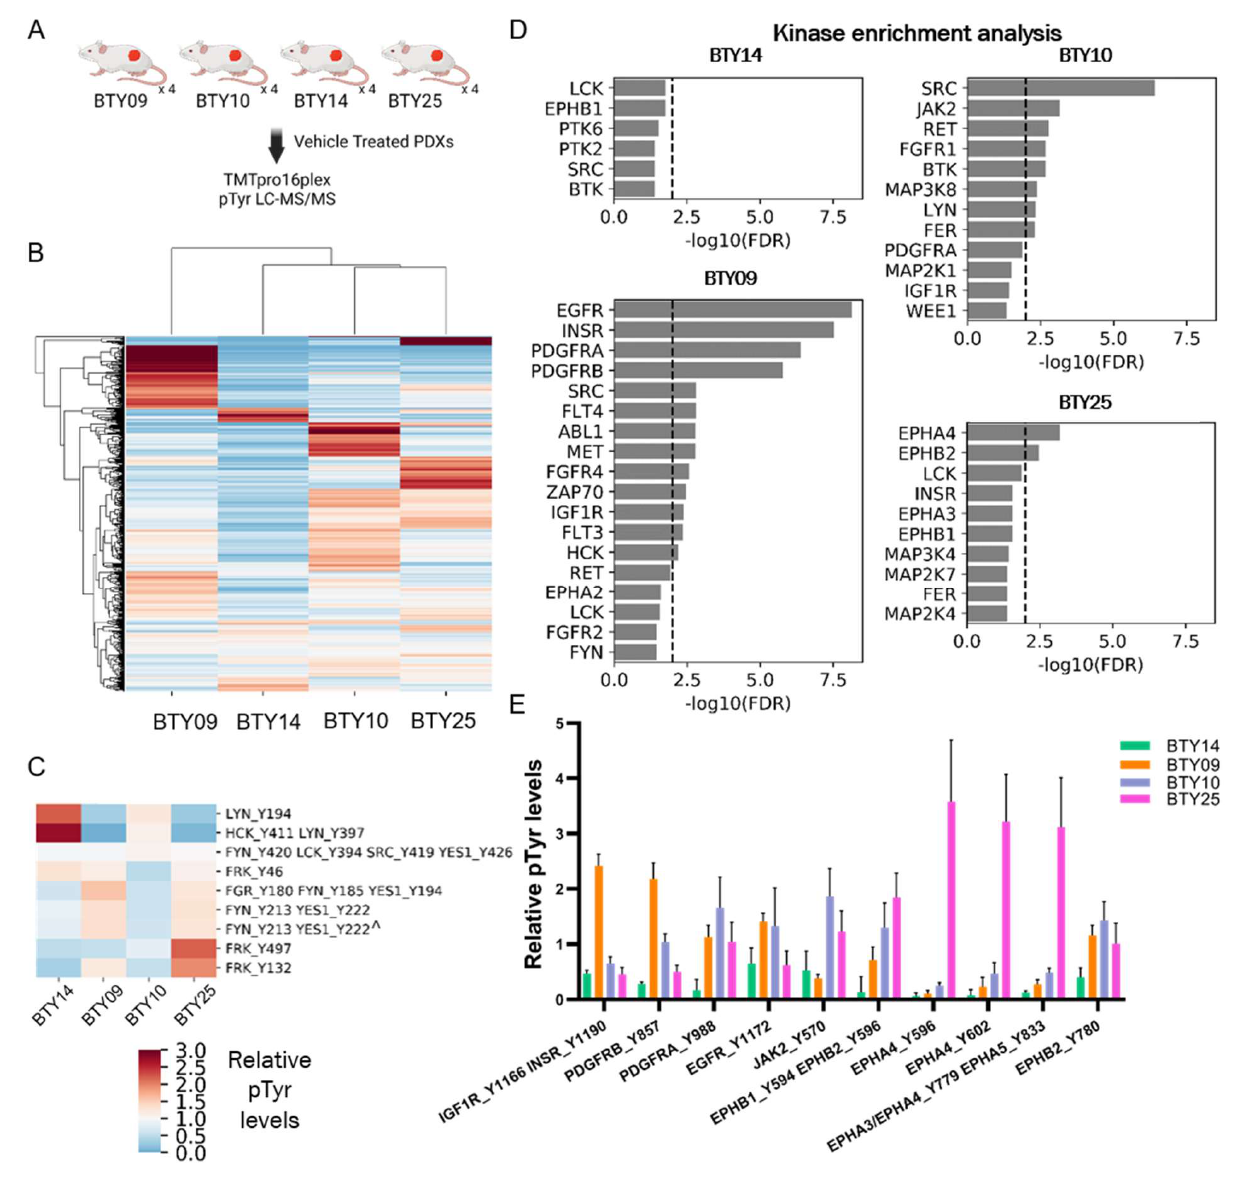
Figure 3. Phosphoproteomic analysis of vehicle-treated tumors, to assess differential dasatinib sensitivity. ( A ) Workflow schematic of quantitative pTyr analysis of vehicle-treated tumors. ( B ) HCA heatmap of pTyr peptides quantified in PDX tumors ( n = 4/PDX line, total 16 PDXs). ( C ) Heatmap of phosphorylation levels of tyrosine sites belonging to SFKs. Miscleaved peptides are represented by ^. ( D ) Kinase enrichment analysis (KEA) of highly phosphorylated tyrosine sites in each PDX line. KEA was performed on pTyr sites with a greater than 1.5 fold change in each PDX line. Kinases with FDR q-value < 0.05 are shown in the plots. Dashed line depicts FDR q-value = 0.01. ( E ) Phosphorylation levels of selected tyrosine kinases that were enriched in Figure 3D.